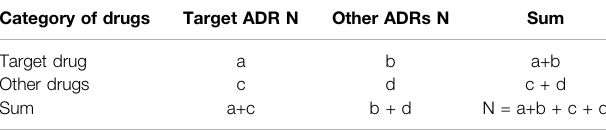
TABLE 1 | The fourfold table used in measures of disproportionality. Category of